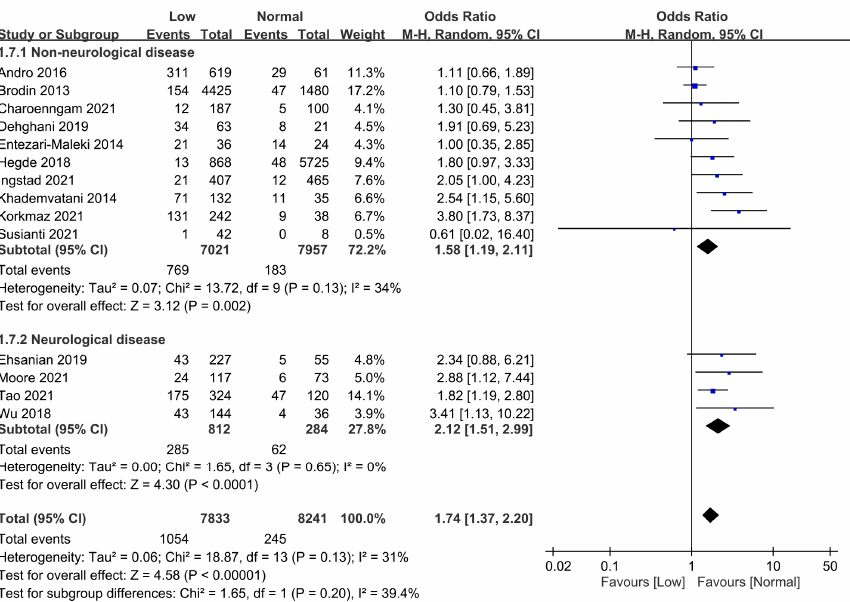
Figure 7. Subgroup analysis focusing on the influence of study design (i.e., non-case-control vs. case-control) on the association between vitamin D status and the risk of venous thromboembolism. CI, confidence interval; M-H, Mantel-Haenszel. The measure of effect (e.g., an odds ratio) for each of these studies is represented by a square incorporating confidence intervals represented by horizontal lines. The vertical line is “Line of no effect”. The area of each square is proportional to the study’s weight in the meta-analysis. This meta-analysed measure of effect is plotted as a diamond, the lateral points of which indicate confidence intervals for this estimate [18,19,28–33,35–39].